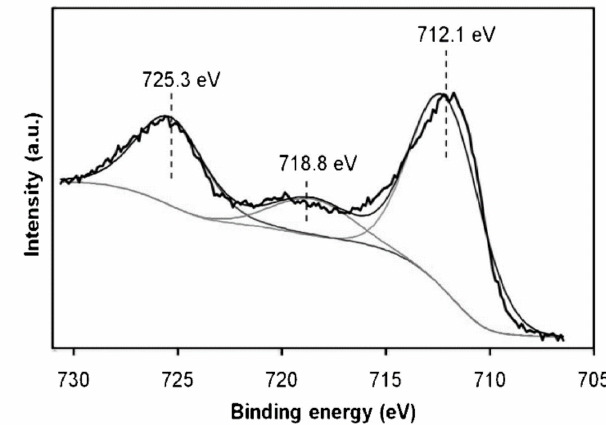
Figure 8. Fe2p XPS spectrum of an activated carbon obtained from lignin by FeCl 3 activation (reprinted from [56] with the permission of Elsevier,